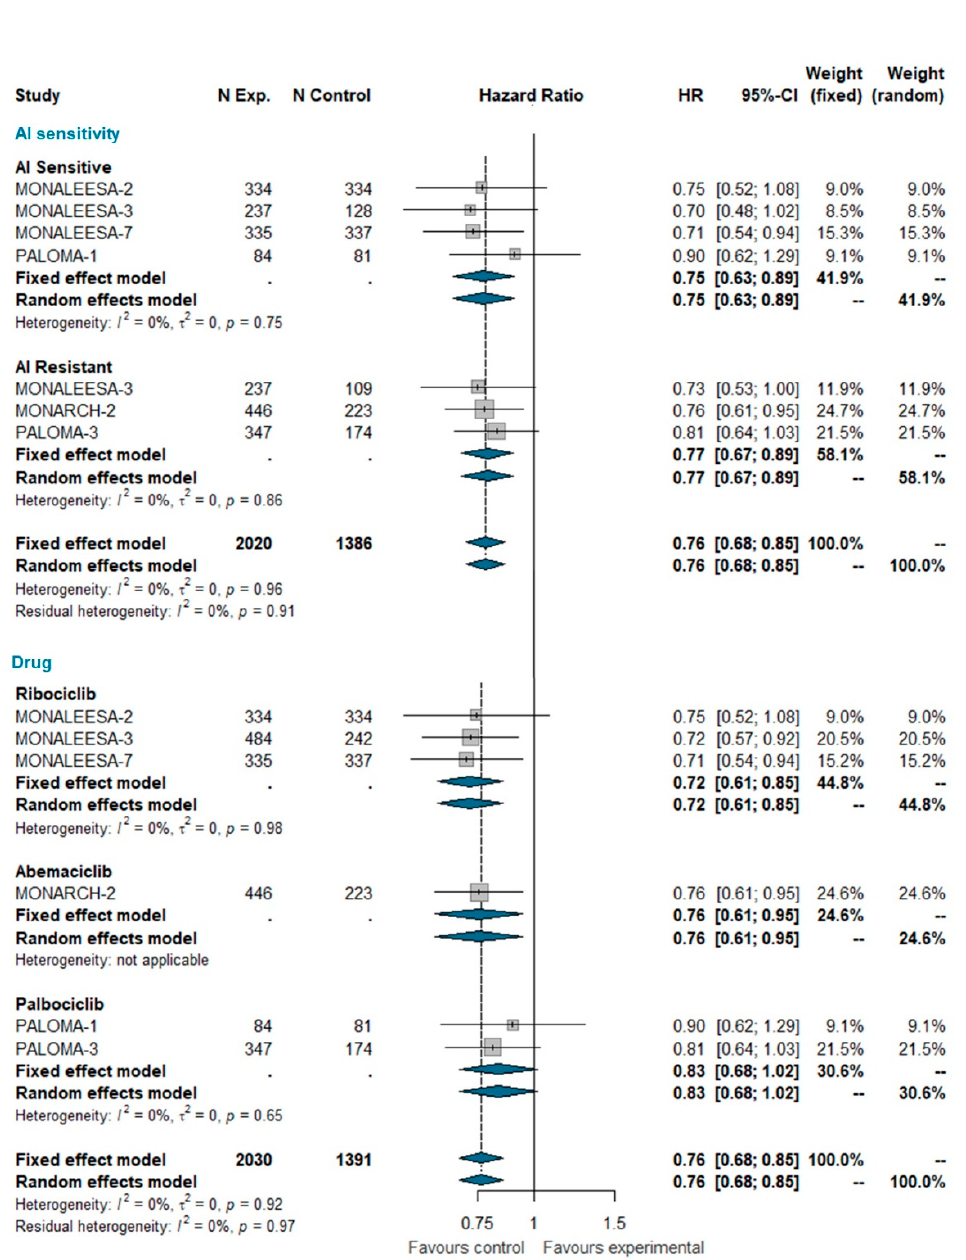
Figure 4. Meta-analysis of overall survival grouped by AI sensitivity (AI sensitive versus AI resistant) and CDK 4/6 inhibitor (Ribociclib, Abemaciclib, Palbociclib). Abbreviations: OS: overall survival; N exp: number of patients randomized in experimental arm; N control: number of patients randomized in control arm; HR: hazard ratio; CI: confidence interval; AI: aromatase inhibitors).